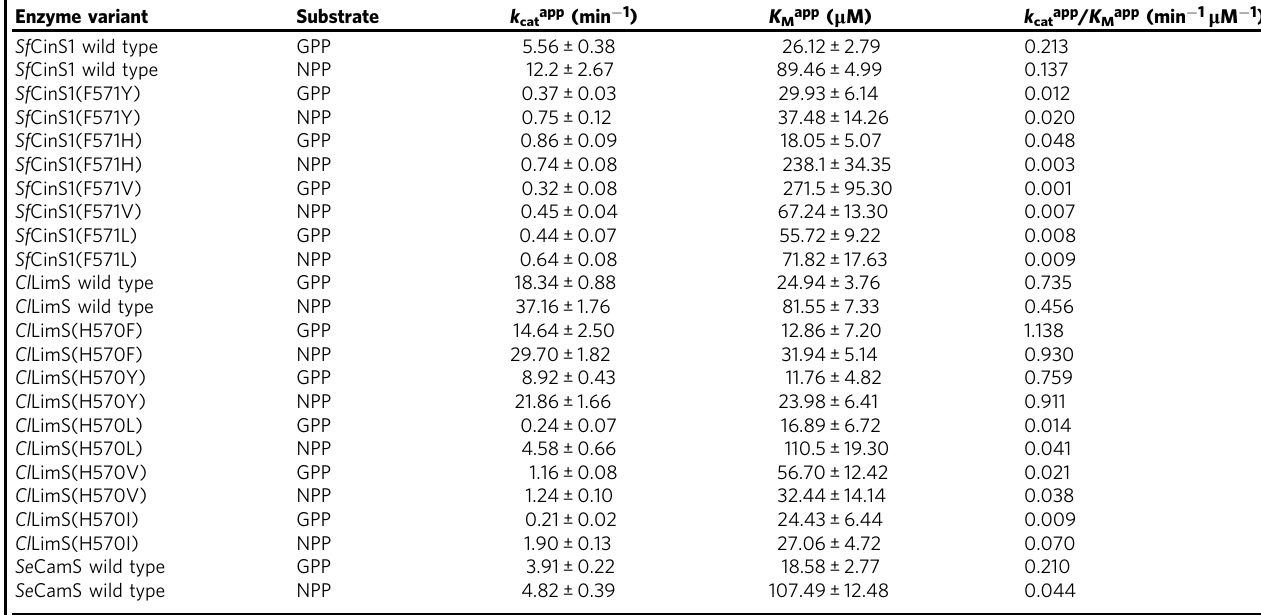
Table 1 Kinetic parameters of terpene synthases and variants Enzyme